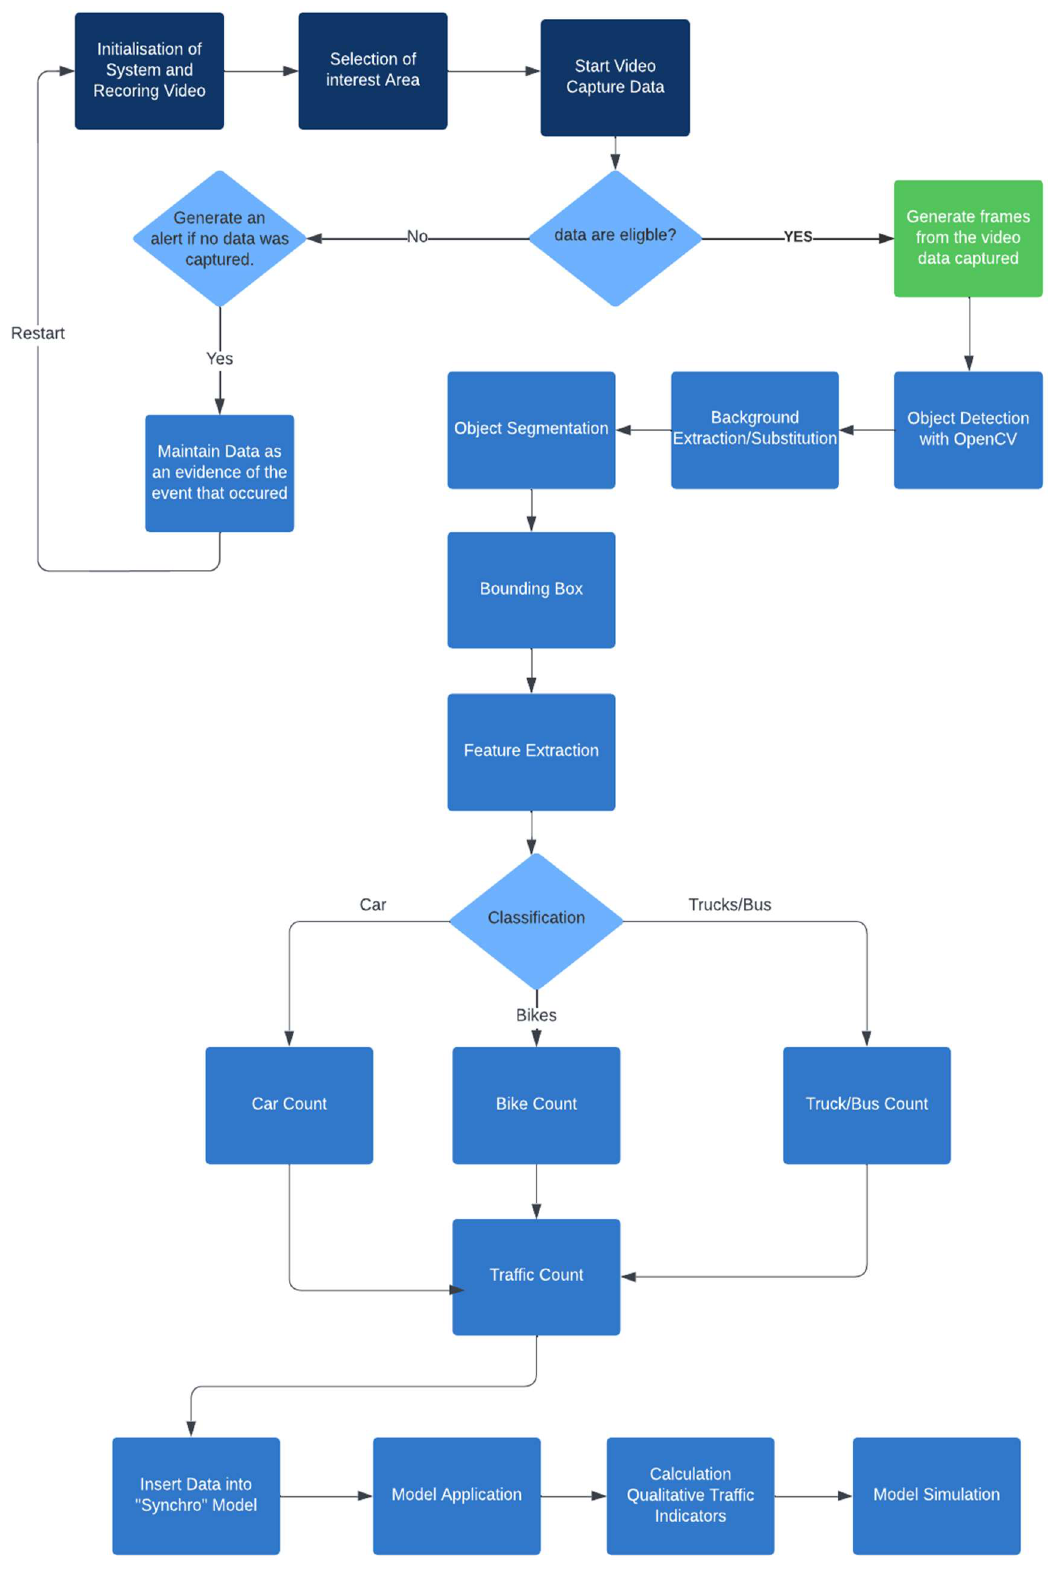
Figure 3. Process and methodology used for the traffic count. Parts of the analytical pseudo Algorithms 1 and 2 are shown below.